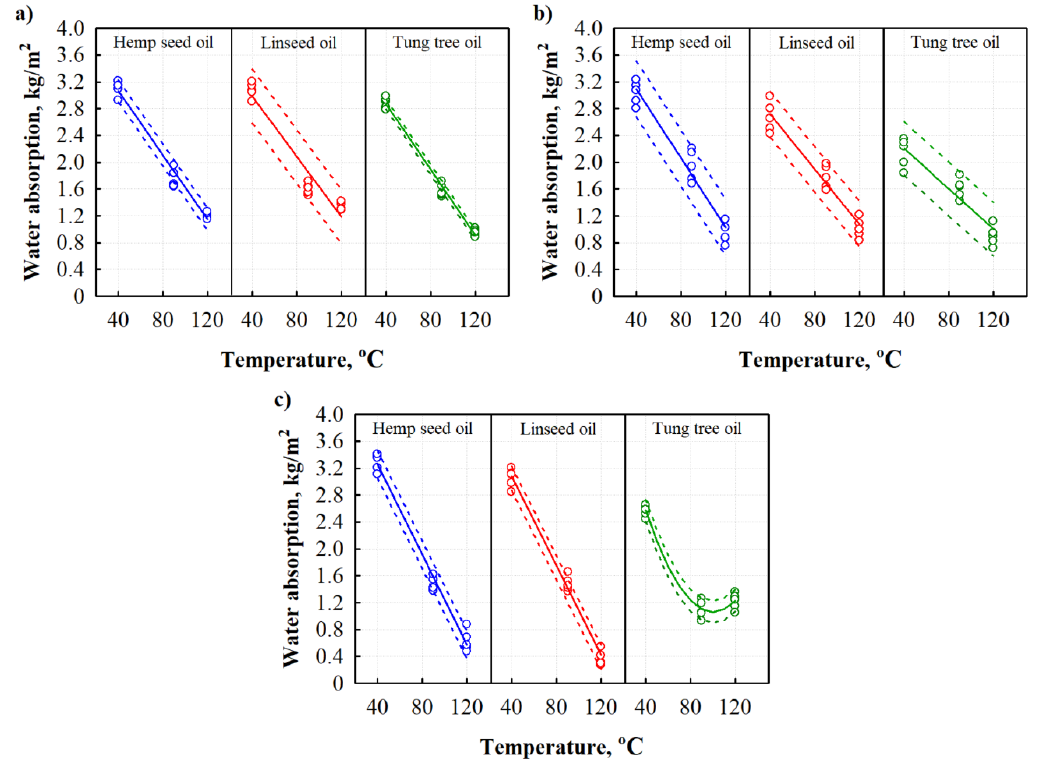
Figure 2. Dependences of water absorption on hardening temperature of different oils-impregnated BcBs: ( a ) F composition; ( b ) G composition; and ( c ) H composition.